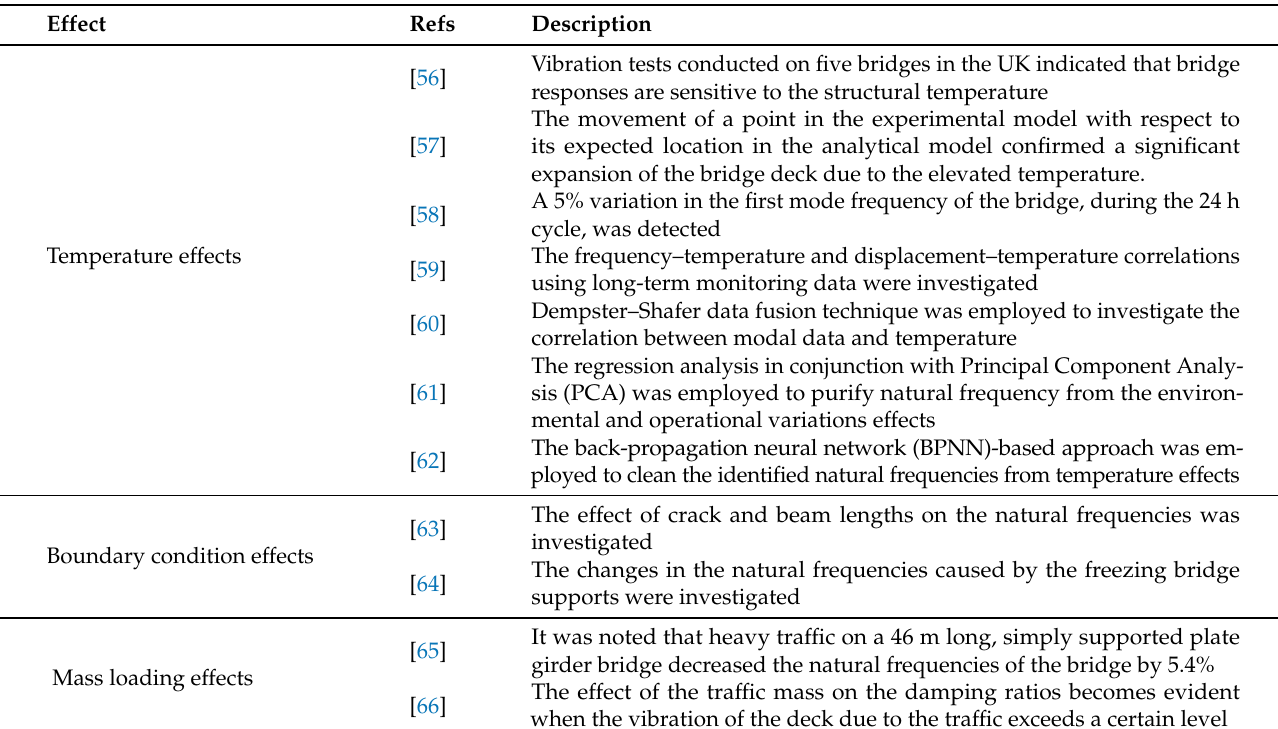
Table 4. Some references studying the environmental and operational